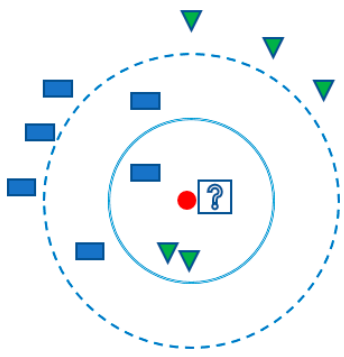
/ Figure 6. Example of k-nearest neighbors (KNN) regression/classification. Figure 6. Example of k-nearest neighbors (KNN) regression Figure 6. Example of k-nearest neighbors (KNN) regression/classification. Figure 6. Example of k-nearest neighbors (KNN) regression/classification. Figure 6. Example of k-nearest neighbors (KNN) regression/classification. Figure 6. Example of k-nearest neighbors (KNN) regression/classification. Figure 6. Example of k-nearest neighbors (KNN) regression/classification.